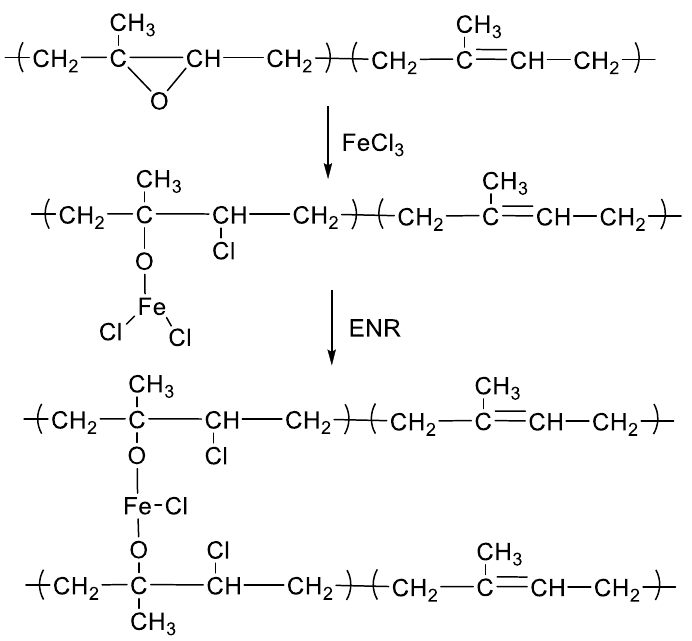
Figure 2. A proposed reaction mechanism between epoxidized natural rubber and ferric chloride. The nucleophilic chloride is attached with β position with respect to the methyl group.